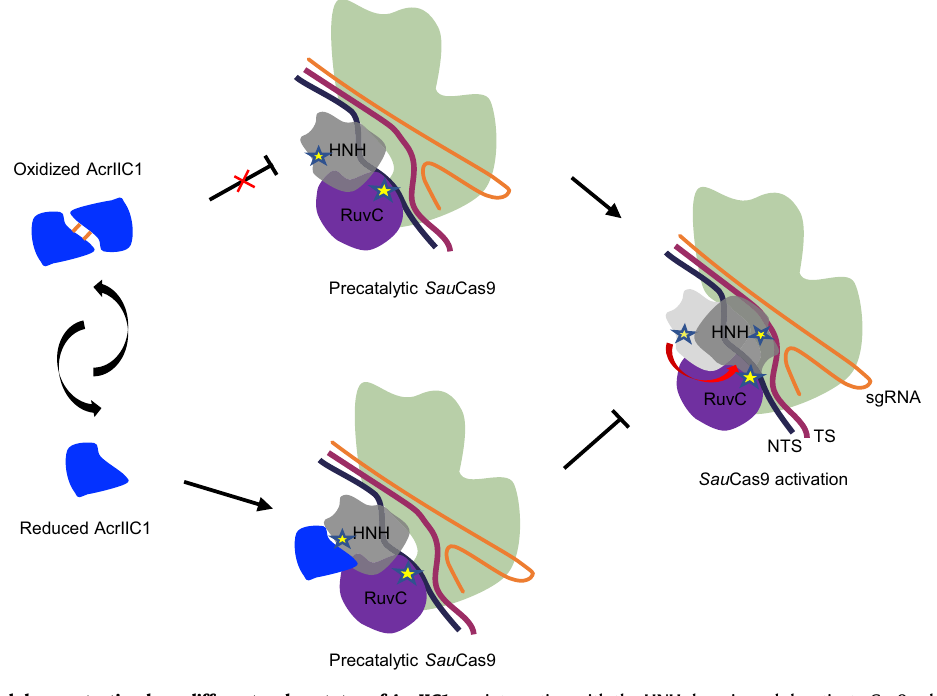
interaction with the HNH domain and deactivate Cas9, while oxidized AcrIIC1 dimer would bury the contact interface with HNH, therefore loses its anti-Cas9